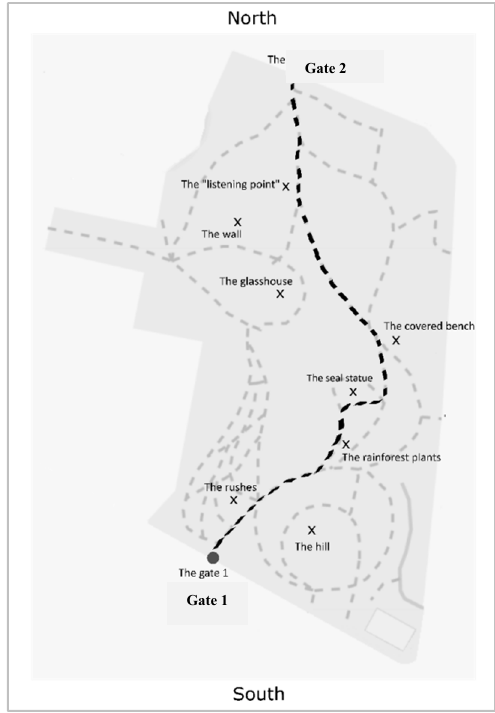
Figure 1. Map of the Europe Park (Padova, Italy), showing the path (black dashed line) and the eight landmarks considered (marked with an X), Gate 1 (to the south) and Gate 2 (to the north). Map retrieved and adapted from www.openstreetmap.org.